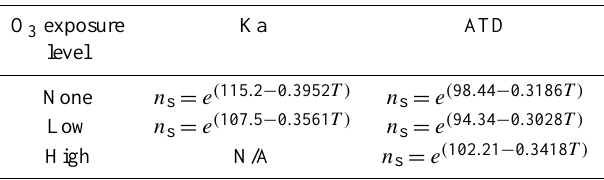
Table 6. Fits for immersion mode ice-active surface site density (m − 2 ) as a function of temperature (K) as shown in Fig. 10. O 3 exposure level Ka